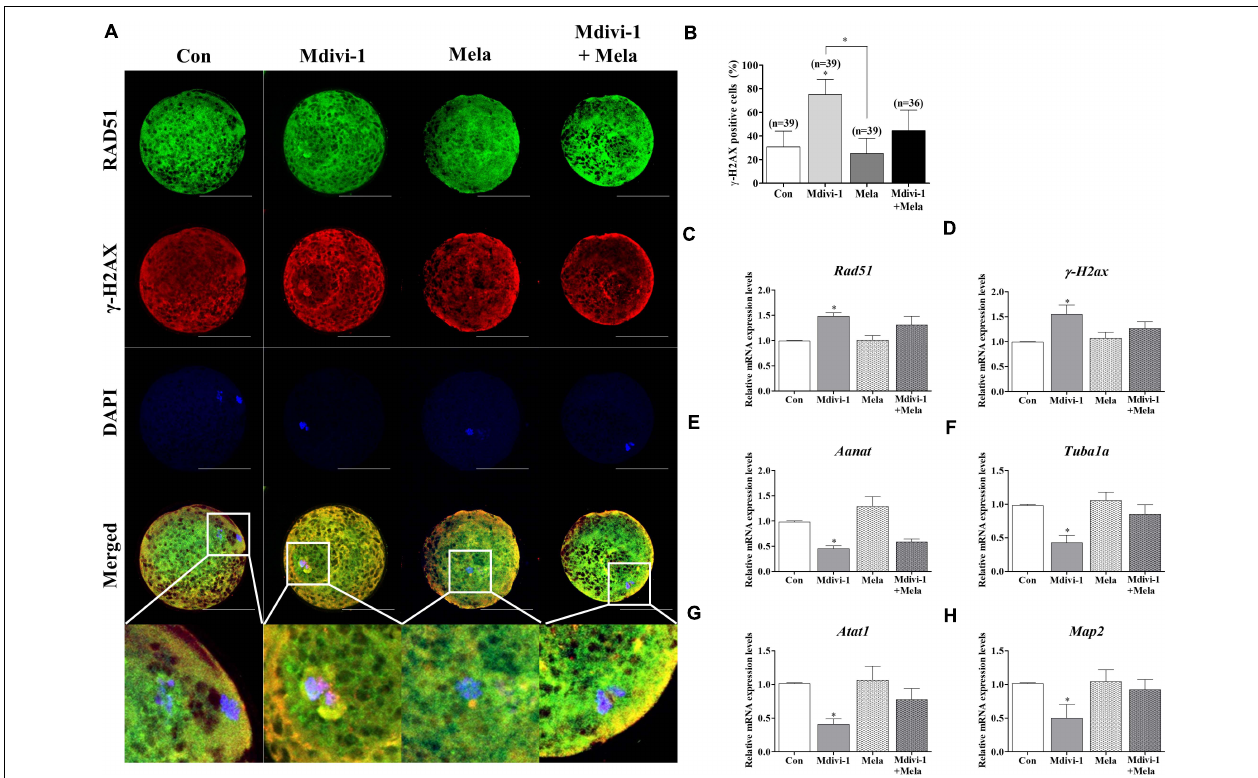
FIGURE 8 | Effects of melatonin on the DNA damage and tubulin formation-related genes in mature porcine oocytes. (A) Immunofluorescence of RAD51 and γ -H2AX protein expression of mature porcine oocytes. Scale bar: 100 µ m. (B) Percentage of γ -H2AX-positive cell ratios in the control, mitochondrial division inhibitor 1 (Mdivi-1), melatonin, and Mdivi-1 + melatonin groups of mature porcine oocytes. (C,D) Expression levels of DNA damage-related genes ( Rad51 and γ -H2ax ) in the control, Mdivi-1, melatonin, and Mdivi-1 + melatonin groups. (E) Expression levels of the melatonin synthesis enzyme gene ( Aanat ) in the control, Mdivi-1, melatonin, and Mdivi-1 + melatonin groups. (F–H) Expression levels of tubulin formation-related genes ( Tuba1a , Atat1 , and Map2 ) in the control, Mdivi-1, melatonin, and Mdivi-1 + melatonin groups. Data in the bar graph represent the mean ± SEM of three independent experiments ( ∗ p <